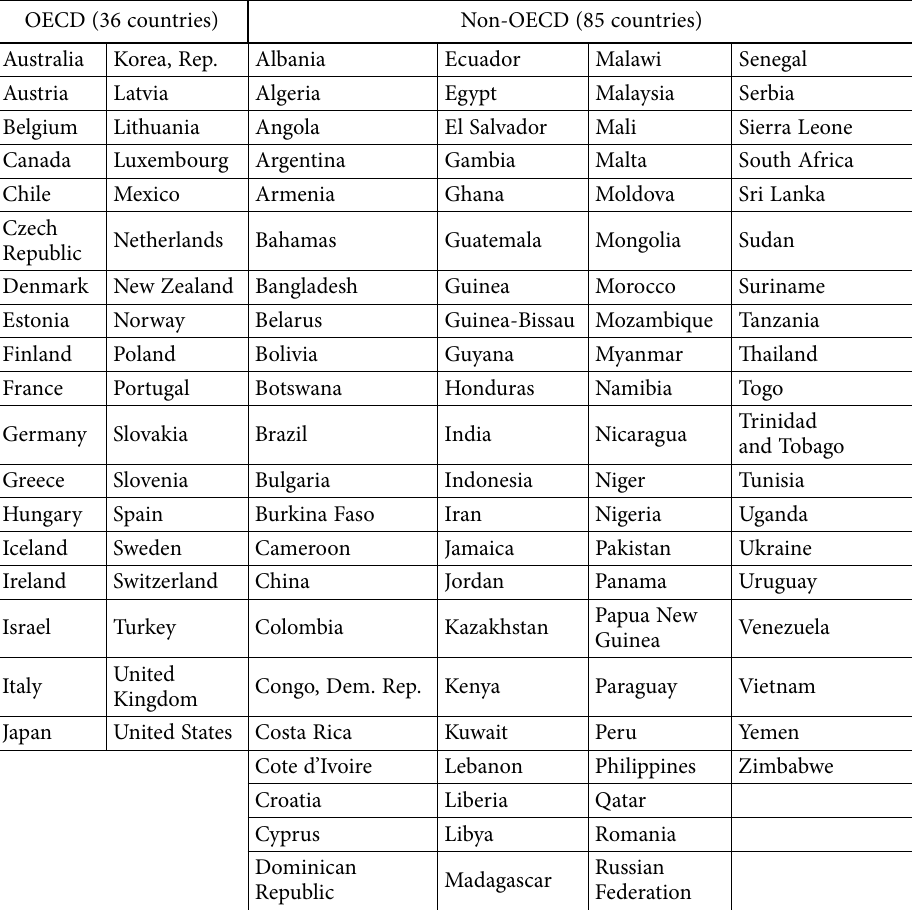
Table A3. List of countries classified by development level OECD (36